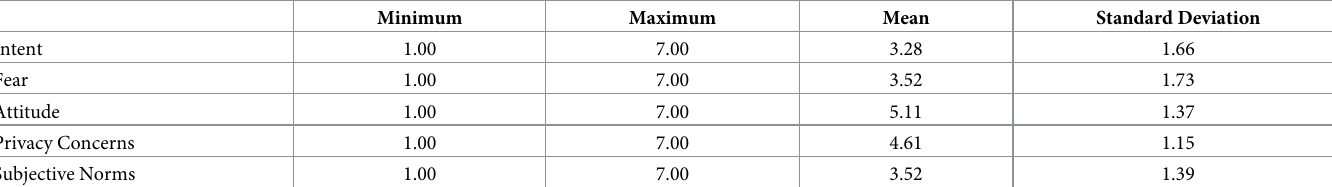
Table 2. Descriptive statistics (N = 229 for all variables).